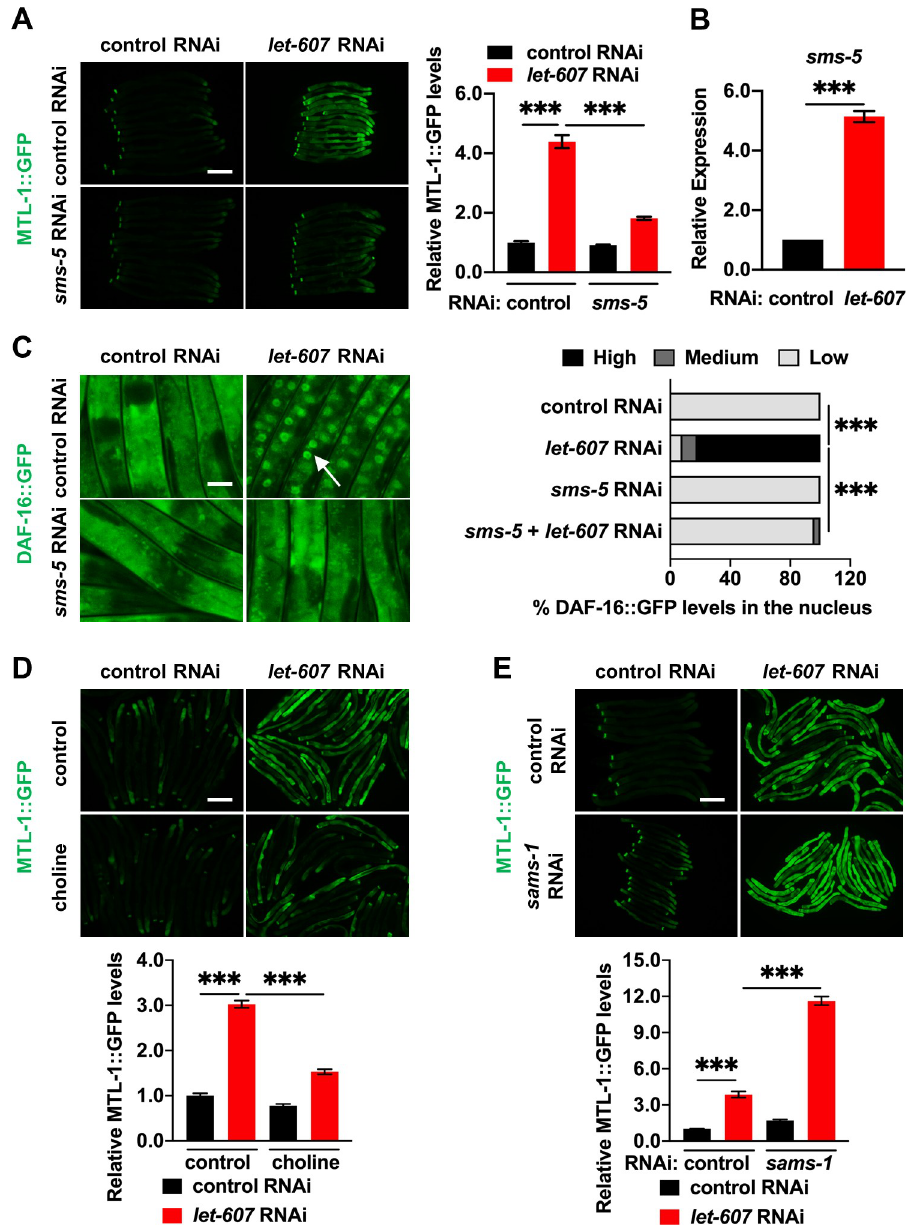
Fig 4. The sphingomyelin synthase SMS-5 mediates DAF-16 activation upon let-607 knockdown. (A) Effects of sms-5 RNAi on let-607 RNAi-induced MTL-1::GFP expression. Left panel, representative images. Right panel: quantification data. Scale bar = 100 μ m. (B) Effects of let-607 RNAi on the sms-5 mRNA expression. n = 3 per group. (C) Effects of sms-5 RNAi on let-607 RNAi-induced DAF-16::GFP nuclear occupancy. Left panel, representative images. White arrow indicates nuclear GFP signal. Right panel: semi-quantification data. Number of animals (n): control RNAi (97), let-607 RNAi (87), sms-5 RNAi (80) and sms-5 + let-607 RNAi (48). Scale bar = 25 μ m. (D) Influence of choline on MTL-1::GFP expression in let-607 RNAi-treated animals. (E) MTL-1::GFP expression in WT and let-607 knockdown animals after sams-1 RNAi. Upper panel, representative images. Lower panel: quantification data. Scale bar = 100 μ m. Data were presented as mean ± SEM. ��� p < 0.001.